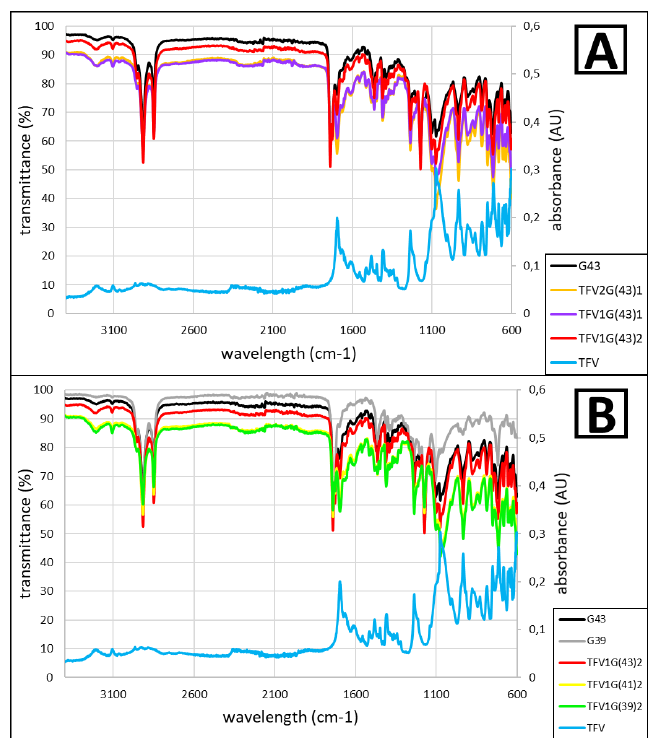
Figure 1. FTIR-ATR spectra of TFV, G43 and their combinations ( A ); and TFV, G43, G39 and their combinations in a 1:2 ratio of TFV/Gelucire® ( B ). The absorbance spectra (right axes) correspond to TFV.